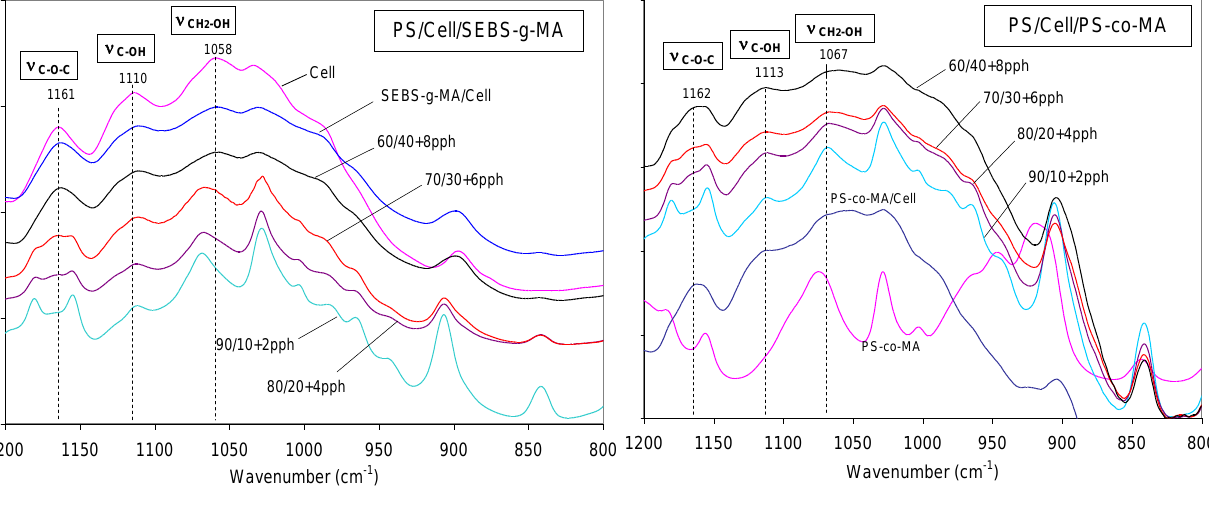
Figure 12. Values of elastic modulus for PS/Cell, PS/Oat and PS/CaCO